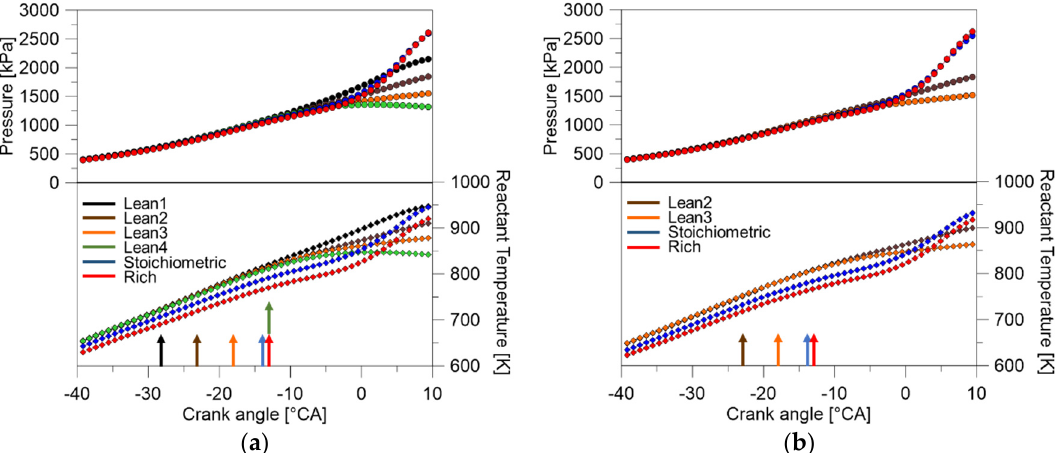
Figure 7. Reactant temperature and pressure in the first stages of the combustion process for ( a ) gasoline and ( b ) E30. The arrows indicate the STs.